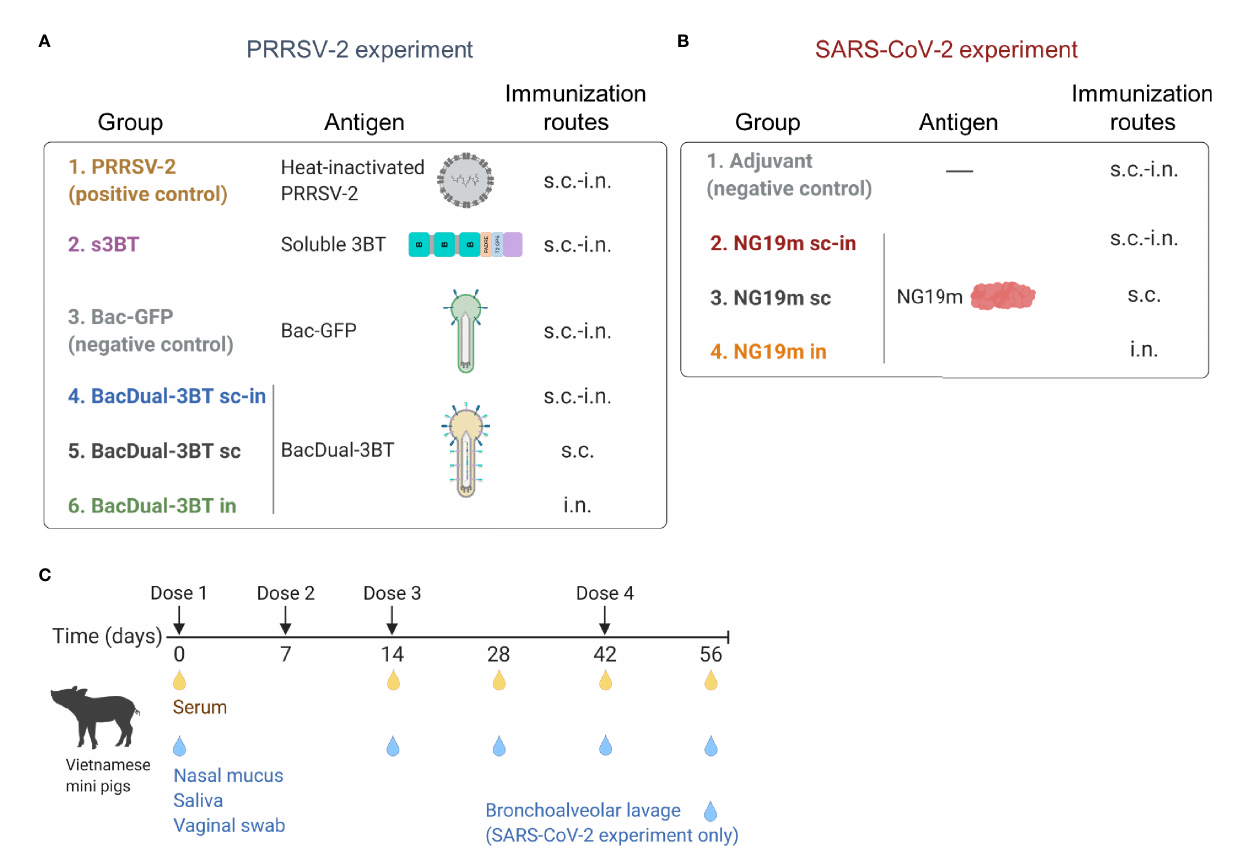
FIGURE 2 | Groups of immunized animals and the immunization/sample collection schedule in PRRSV-2 and SARS-CoV-2 experiments. (A, B) Schematic representation of antigens and immunization routes assessed in each experiment. Groups were constituted of four (Bac-GFP) to fi ve or six animals (rest of the groups). (C) Two and three-month-old, SPF weaned Vietnamese male and female mini-pigs were employed in both experiments. Timepoints of immunization and serum/mucosal sample collection are indicated. Figure created with